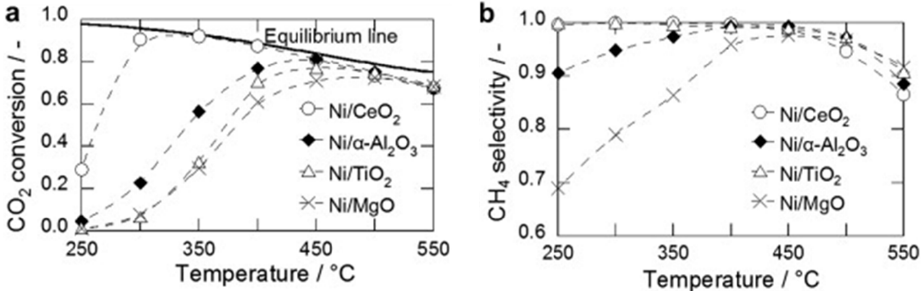
Figure 14. Effect of support materials on ( a ) CO 2 conversion and ( b ) CH 4 selectivity over Ni/CeO 2 , Ni/α-Al 2 O 3 , Ni/TiO 2 , and Ni/MgO. Reaction conditions: 20 vol% CO 2 , 80 vol% H 2 , GHSV = 10,000 h −1 . Reproduced with permission from [216], Elsevier, 2012.